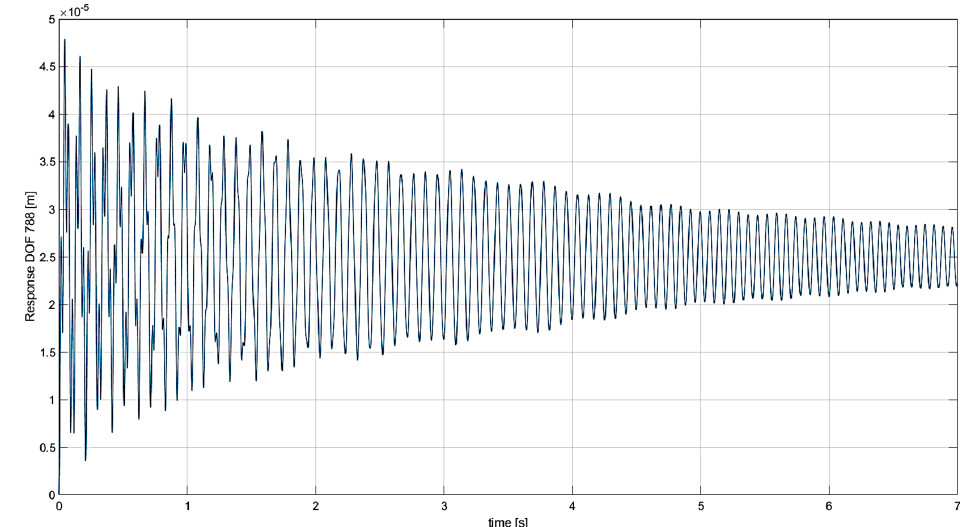
Figure 37. Nosecone deflection without loading.